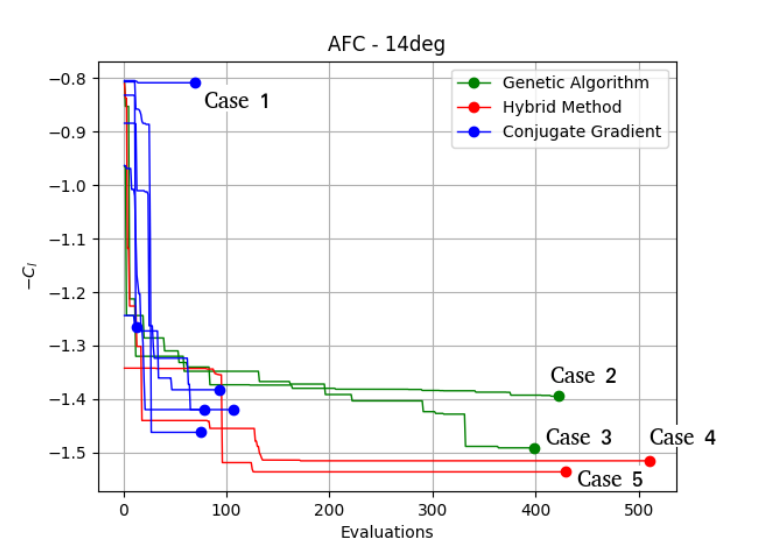
Figure 4. Comparative of the convergence of the different optimization